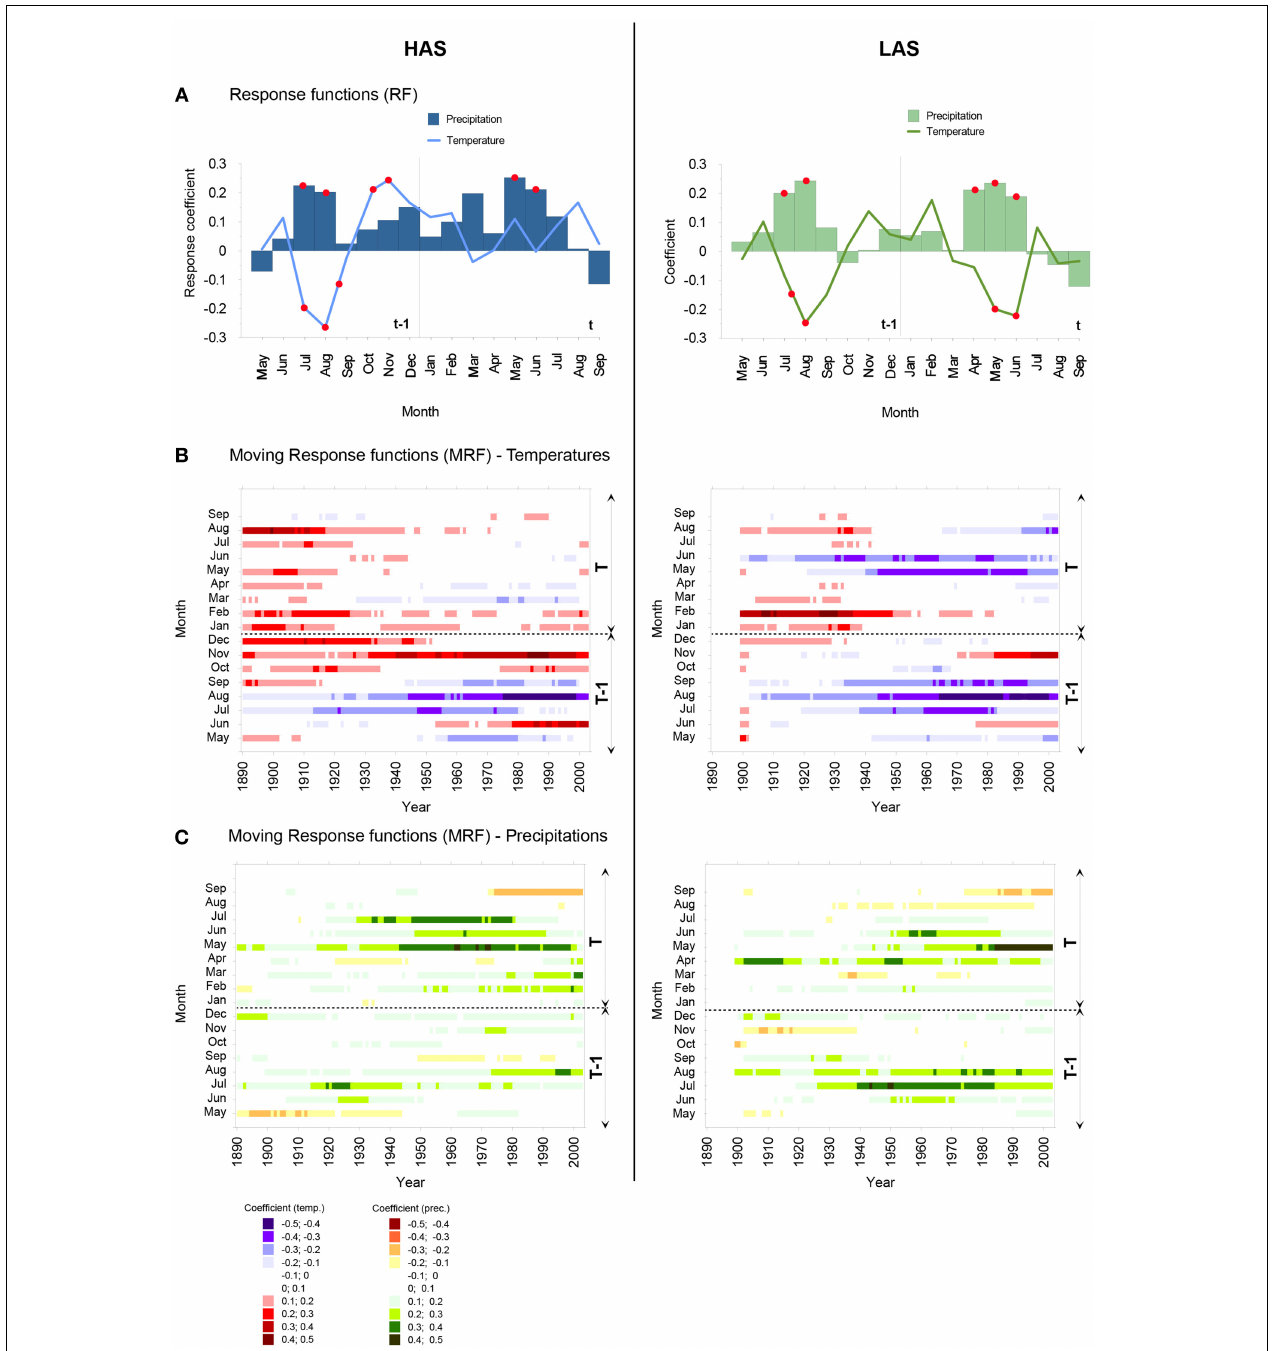
FIGURE 3 | (A) Response function analysis between double detrended chronologies in HAS (blue, left panel) and in LAS (green, right panel), monthly mean temperature and monthly precipitation for the period 1837–2007. Red filled circles indicate significant relationships at p < 0 . 05.